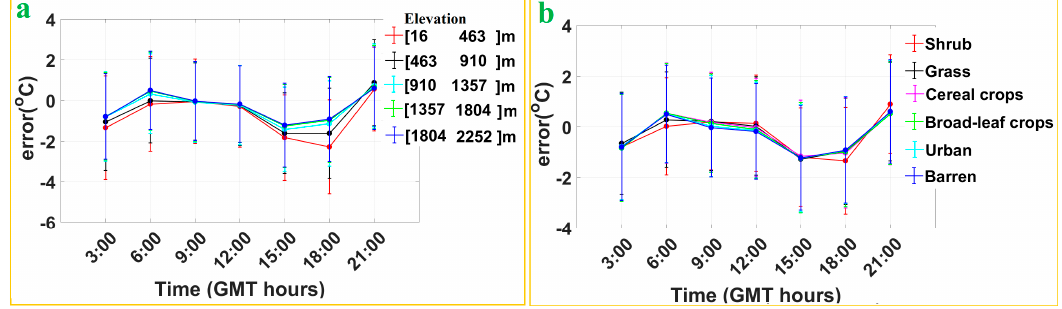
Figure 9. Mean and RMSEs of model errors in weather stations for different land covers and elevation (DEM) classes at different times. ( a ) Elevation class errors, and ( b ) land cover type errors. The error bar of the model in shrub land cover at 18:00 GMT with − 1.34 °C mean error and 2.10 °C RMSE is more separated from others.